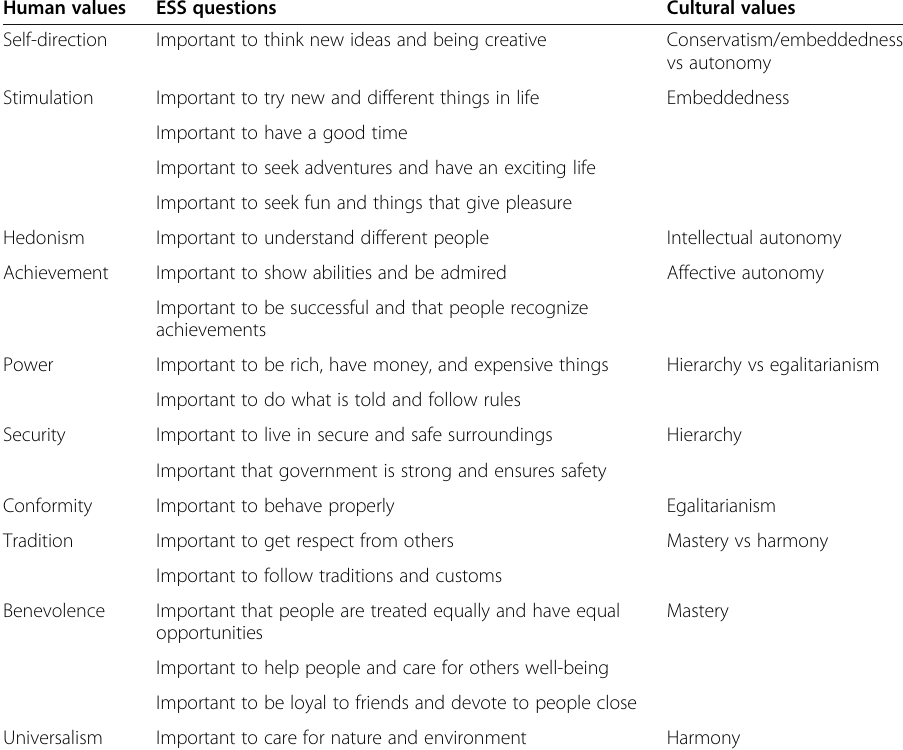
Table 1 Linking Schwartz ’ s values to relevant ESS questions Human